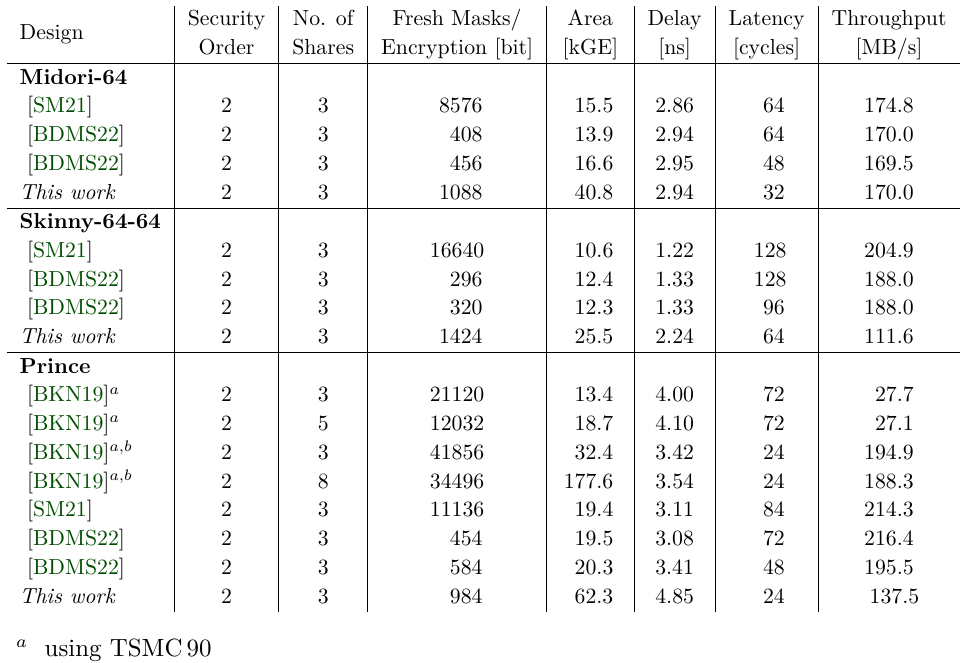
Table 3: Performance figures of different